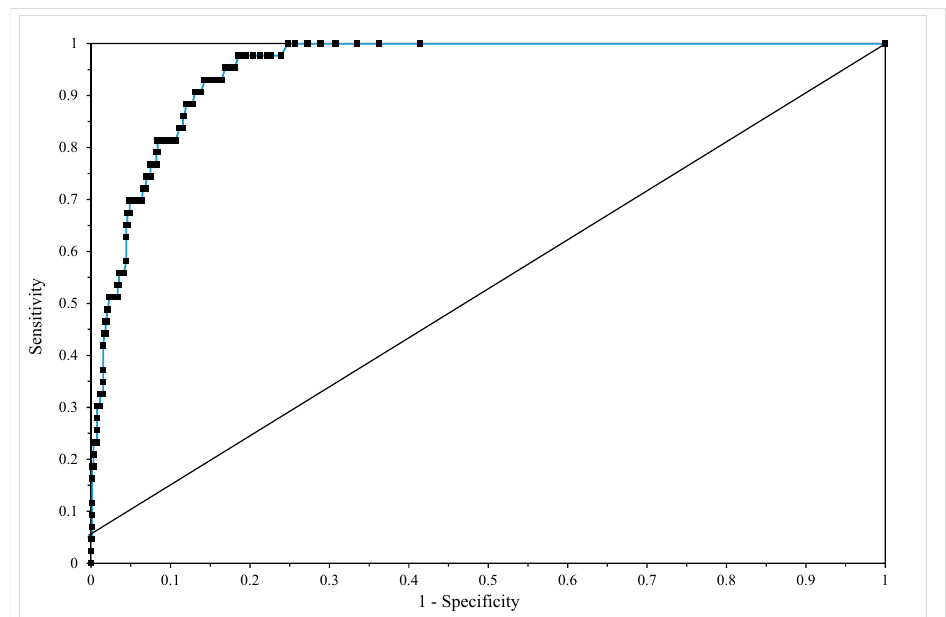
Figure 8. The receiver operating characteristic (ROC) from model given by Equation (19f).